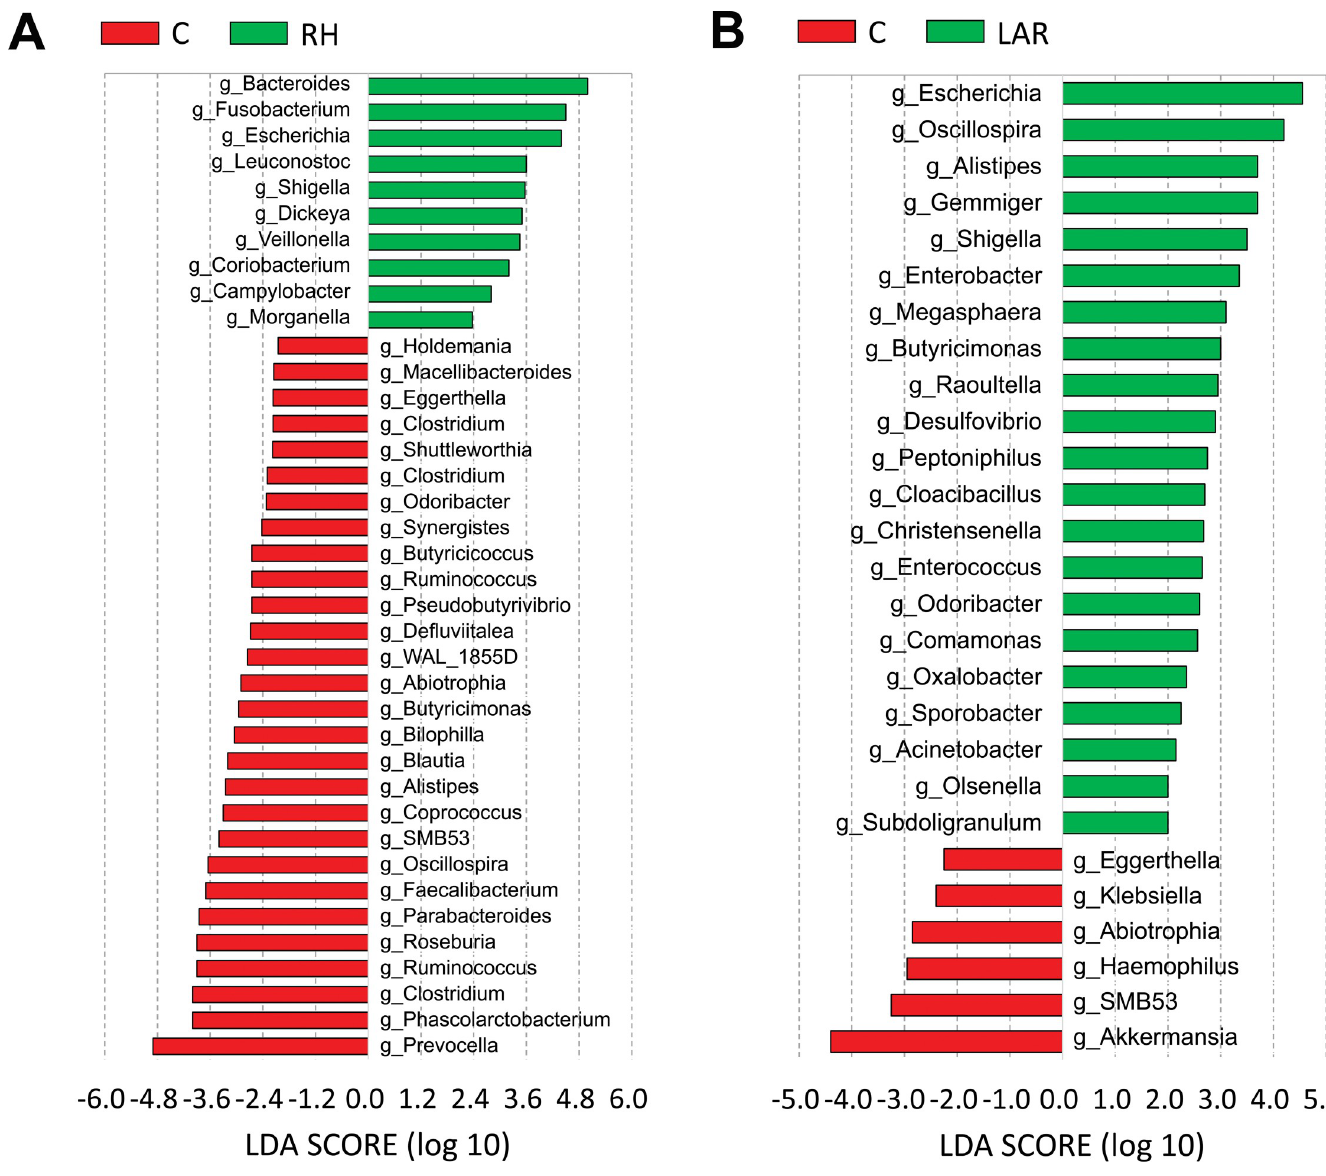
Fig 4. Known genera abundance reported by LEfSe in the bacterial community. Known genera reported by LEfSe in the bacterial community, comparison between right hemicolectomy (RH) and control group (Fig 4A). Known genera reported by LEfSe in the bacterial community, comparison between low anterior resection (LAR) and control (Fig